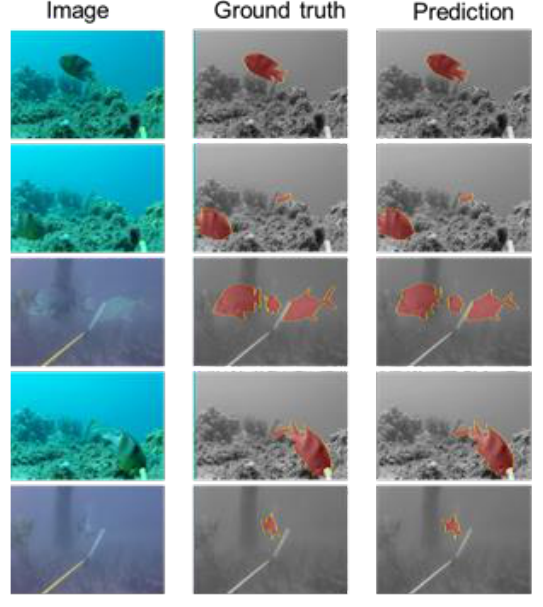
Figure 4. Representative fish segmentation results by the proposed approach on the DeepFish data. The Ground truths and Predictions are overlaid on the gray scale image for better visualization. Table 1. Comparison between other methods for